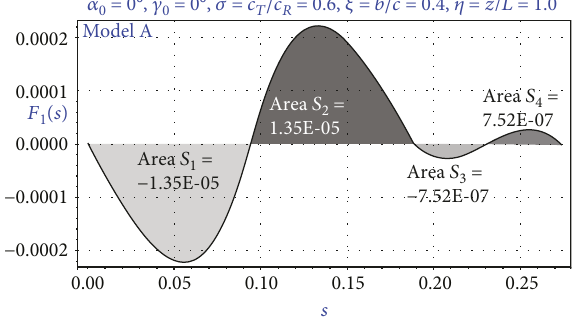
Figure 6: Corrected primary warping functions of Model A.